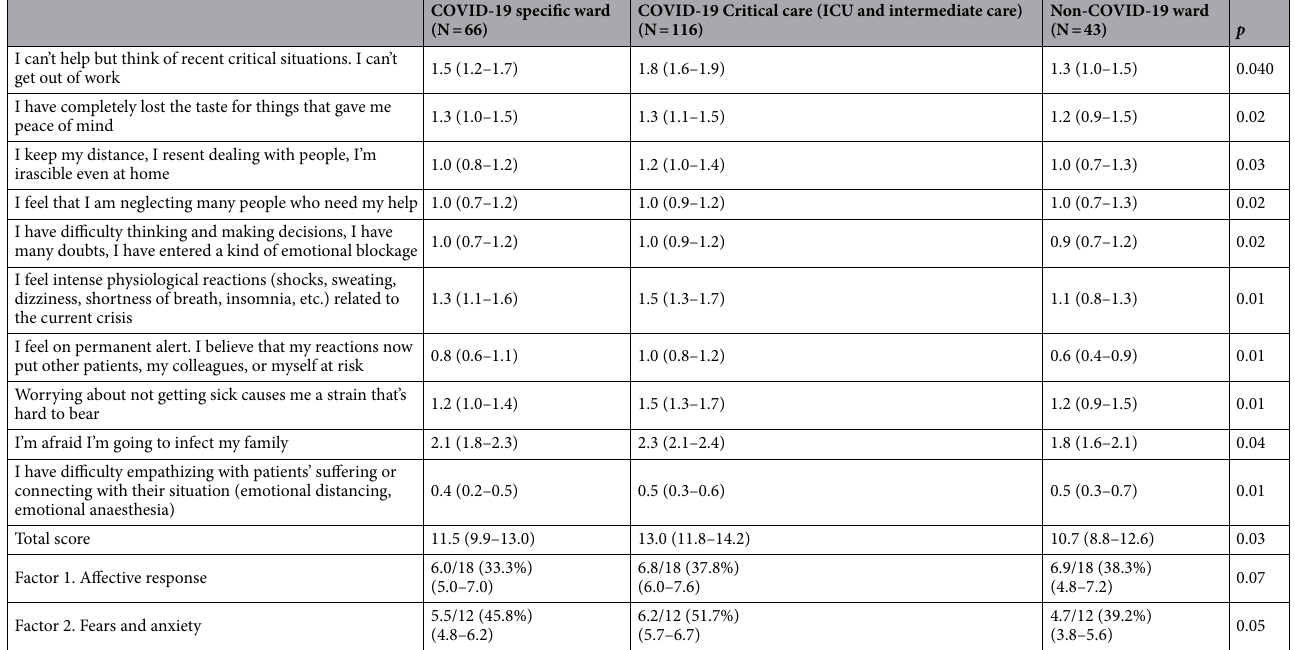
Table 5. Differences in the level of acute stress according to the work area. The Kruskal–Wallis test was performed for the comparison between groups ( p < 0.05). Scores from 0 to 3 points on each of the items on the scale. Scores from 0 to 30 in total on the scale. Scores from 0 to 18 in factor 1. Scores from 0 to 12 in factor 2.